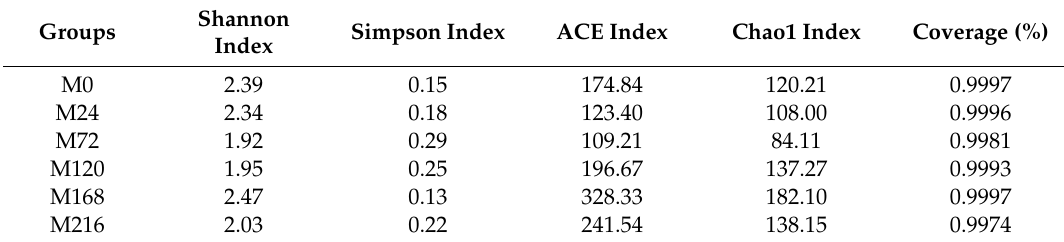
Table 4. Alpha Diversity Indices and Coverage of Spanish